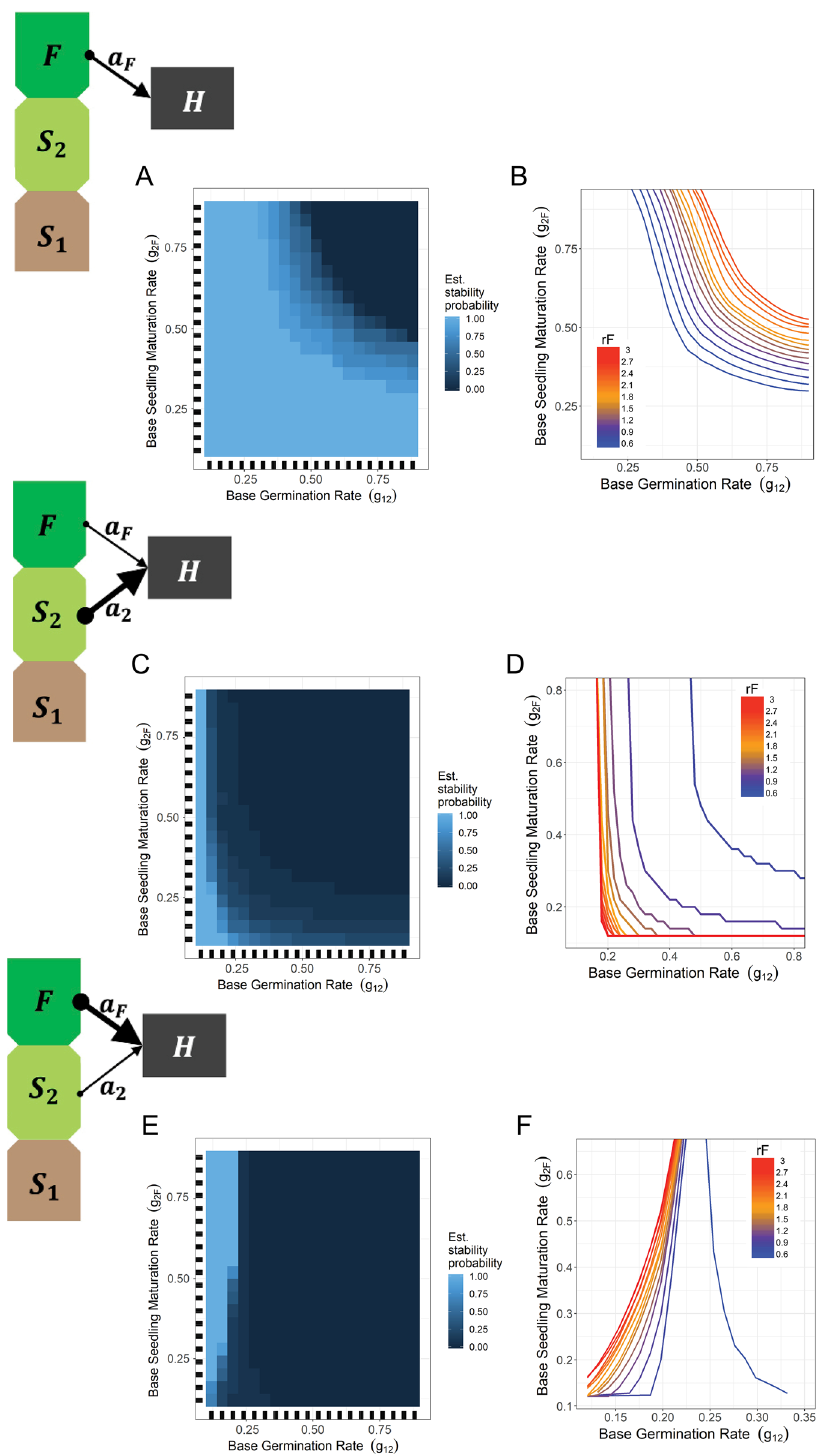
Figure 3. Interactive feature effects on model behavior. Across different herbivory allocations, partial dependence (PD) plots ( A , C , E ) show interactive effects between maturation rates on categorical simulation stability. Threshold plots ( B , D , F ) extend this analysis to include gradations of seed production rates. ( A , B ) Herbivory allocation a F = 1.0 and a 2 = 0.0. ( A ) Partial dependence plot shows probability of stability across all values of r F . ( B ) Threshold plot shows the location of the threshold between stable and unstable dynamics in { g 12 , g 2 F } parameter space as a function of seed production levels ( r F ). ( C , D ) Herbivory allocation a F = 0.2 and a 2 = 1.0. ( C ) Partial dependence plot shows probability of stability across all values of r F . ( D ) Threshold plot shows the location of the threshold between stable and unstable dynamics in { g 12 , g 2 F } parameter space as a function of seed production levels ( r F ). ( E , F ) Herbivory allocation a F = 1.0 and a 2 = 0.2. ( E ) Partial dependence plot shows probability of stability across all values of r F . ( F ) Threshold plot shows the location of the threshold between stable and unstable dynamics in { g 12 , g 2 F } parameter space as a function of seed production levels ( r F